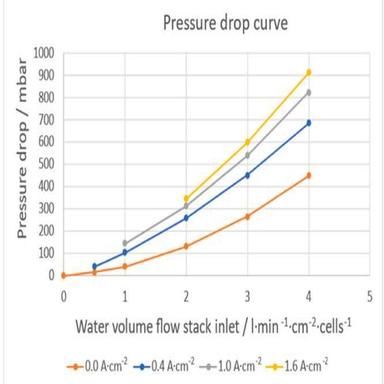
Hydraulic response curves for different current densities.